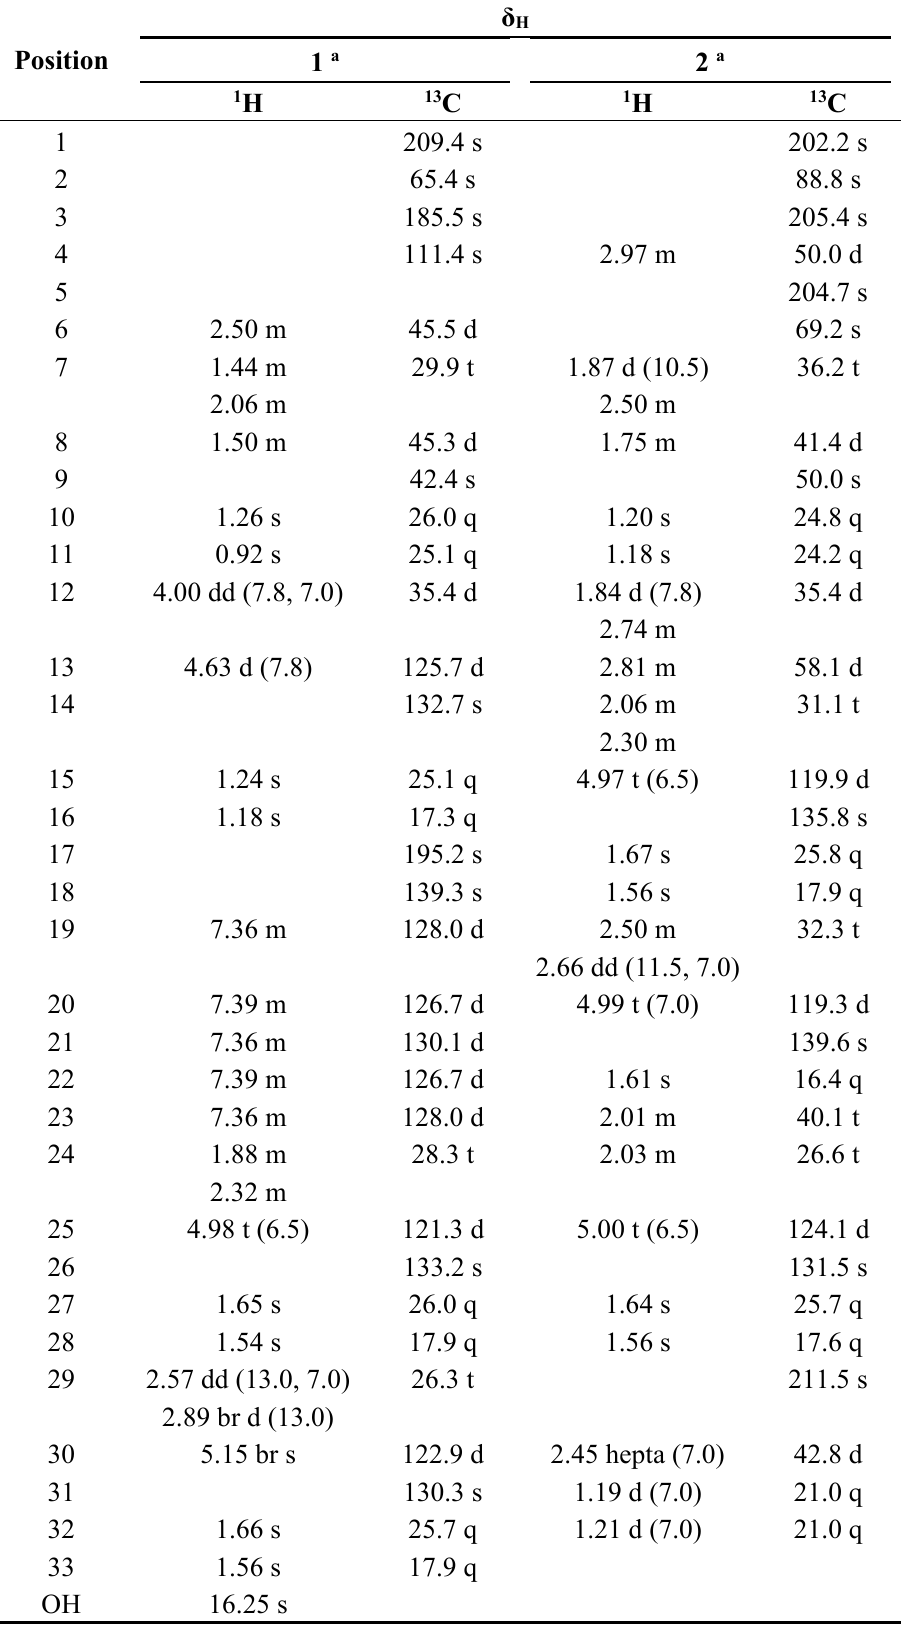
Table 1. 1 H- and 13 C-NMR data of 1 and 2